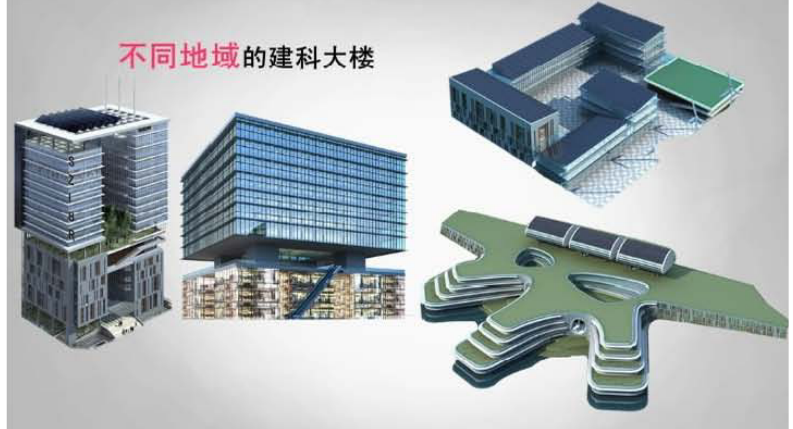
Figure 16. IBR building designs in four different Chinese climates (Chinese text in the figure: IBR Building in different climate zones). From left to right: Urban hot summer (existing building); Urban cold winter; Rural hot dry/cold winter ( above ); and rural hot summer/warm winter ( below